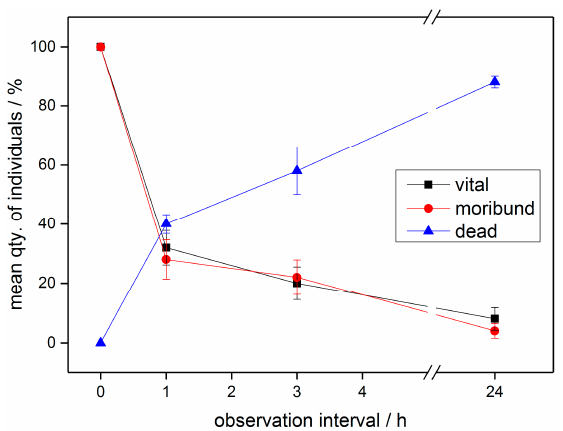
Figure 5. Development of the different vitality states vital, moribund and dead during the MR assessment after PTW treatment of mealybugs ( Planococcus citri ).